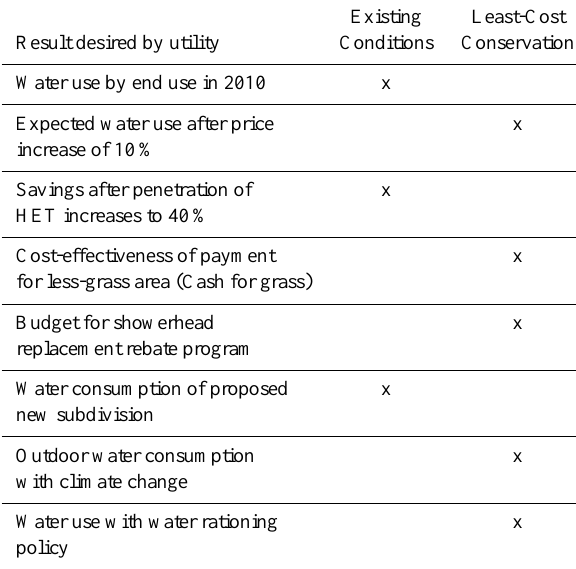
Table 1. Example capabilities of existing conditions and least-cost conservation models.